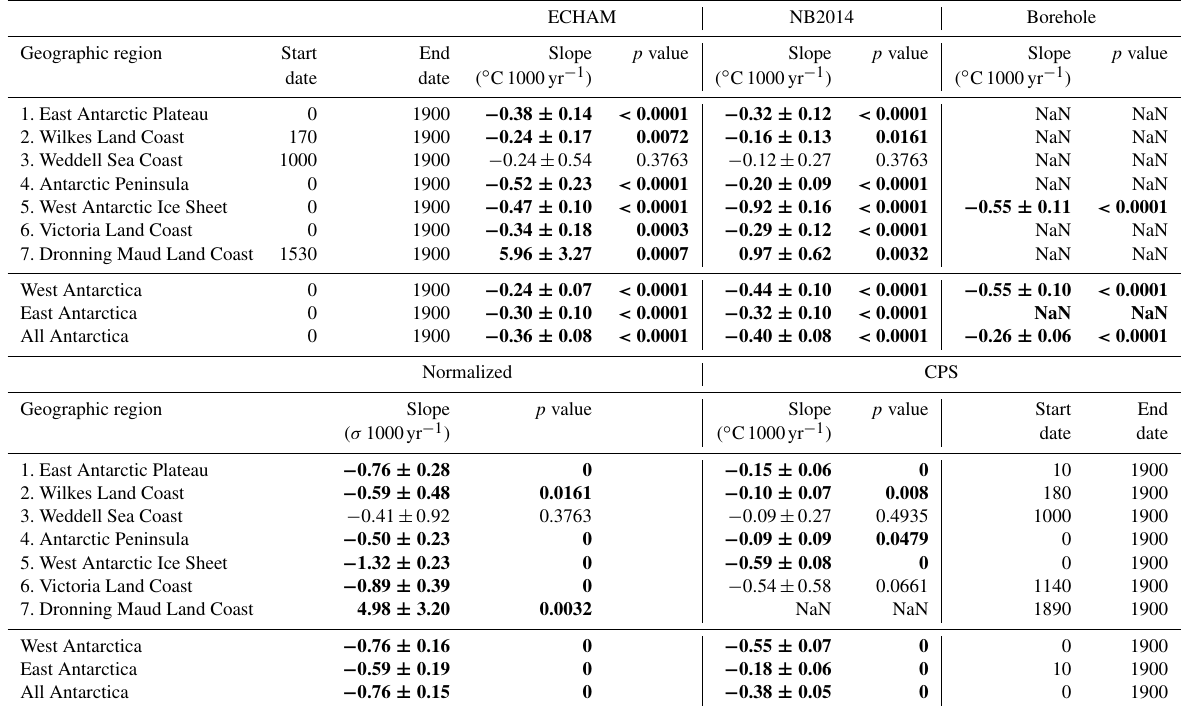
Figure 6. Histograms showing the distributions of all 100-year trends on normalized, weighted composites over the last 2000 years. Distribu- tions are shown for each climatic region, as well as for East, West and whole of Antarctica composites, and are calculated on 10-year-binned composites. The solid vertical lines represent the most recent 100-year trend in each reconstruction, and grey shading corresponds to the 5–95% uncertainty range of the last 100-year trends. Only for the Antarctic Peninsula does the most recent 100-year trend stand out as unusual compared to the natural range of century-scale trends over the last 2000 years. Table 3. Trend analysis of the period 0–1900CE (or shorter depending on maximum record length) for the various temperature scaling approaches detailed in Sect.